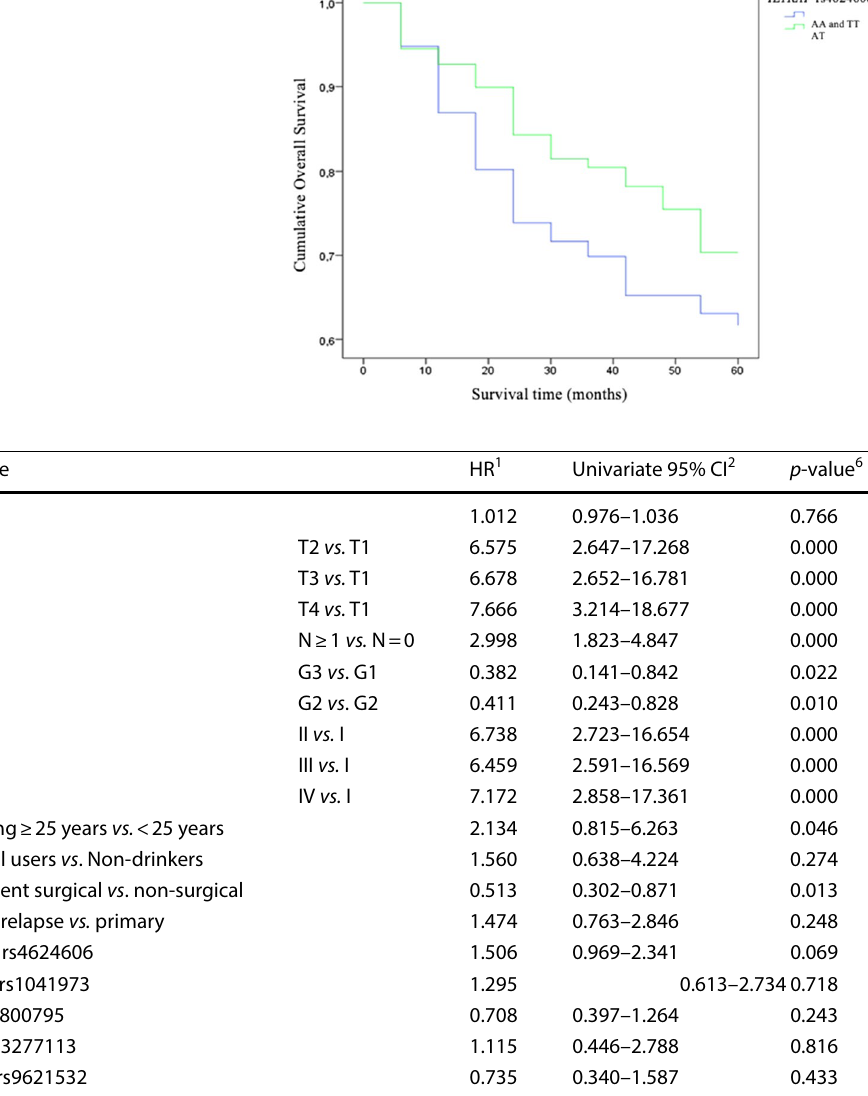
Fig. 1 The 5 year survival rate according to the distribution of IL1RAP rs4624606 geno- types